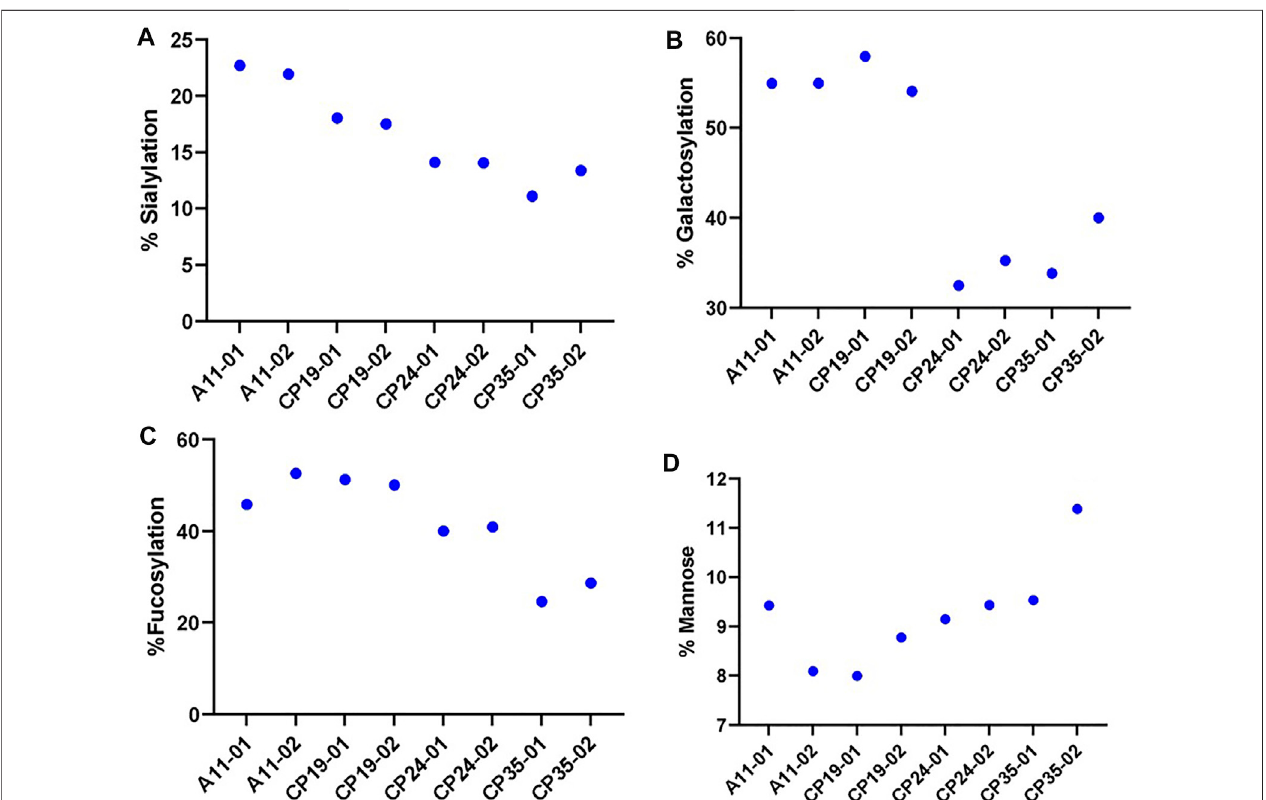
FIGURE 3 | The relative levels of various glycan attribute. (A) Sialylation, (B) Galactosylation, (C) Fucosylation and (D) Mannose content for four different CHO clones (A11, CP19, CP24, and CP35) expressing VRC01 mAb in a 12 days long fed-culture. The suf fi x 01 and 02 represents the biological replicates for each of the